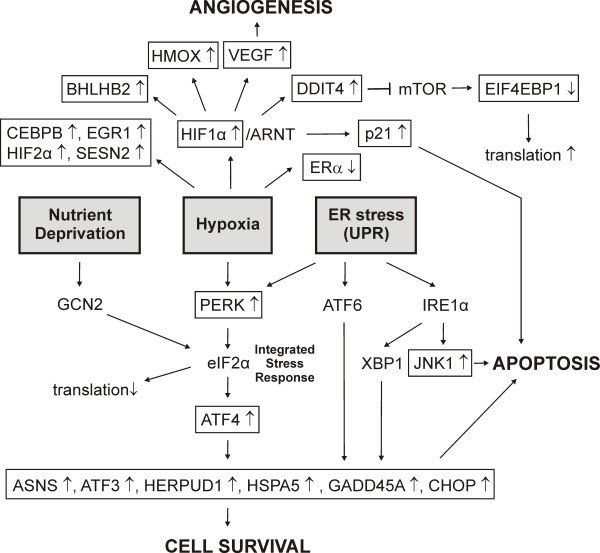
Stress response pathways affected by black cohosh at the transcriptional level. Genes marked by boxes were regulated in MCF-7 cells after treatment with black cohosh extract. ↑ represents up-regulation, ↓ represents down-regulation. (Abbreviations: ATF6, activating transcription factor 6; XBP1, x box binding protein 1; IRE1α, Serine/threonine-protein kinase/endoribonuclease, Inositol-requiring 1).